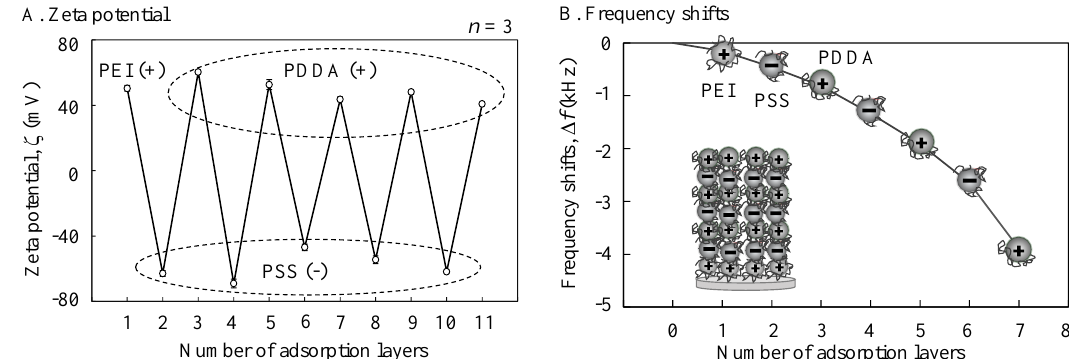
Figure 3. Measured results of frequency shifts for the alternate adsorption of poly(sodium 4-styrenesulfonate) (PSS) / poly(diallyldimethylammonium chloride) (PDDA) on the MF particle cores at 0.5 M of each solvent for 5 min. ( A ) Zeta potential; ( B ) Frequency shifts.